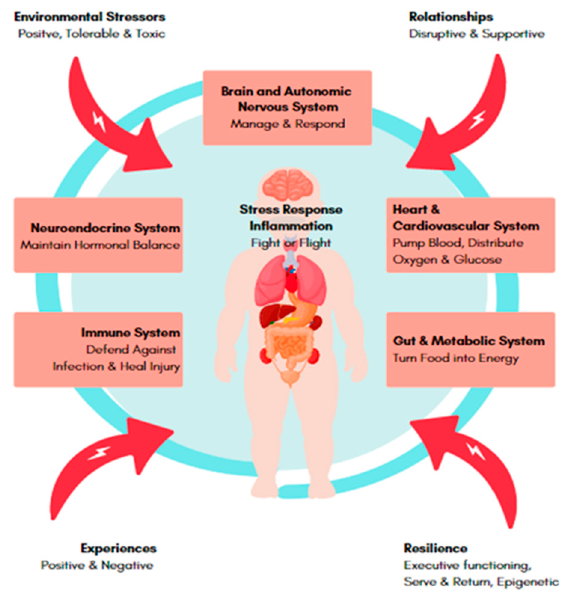
Figure 1. Impact of Stressors on Biological Systems.